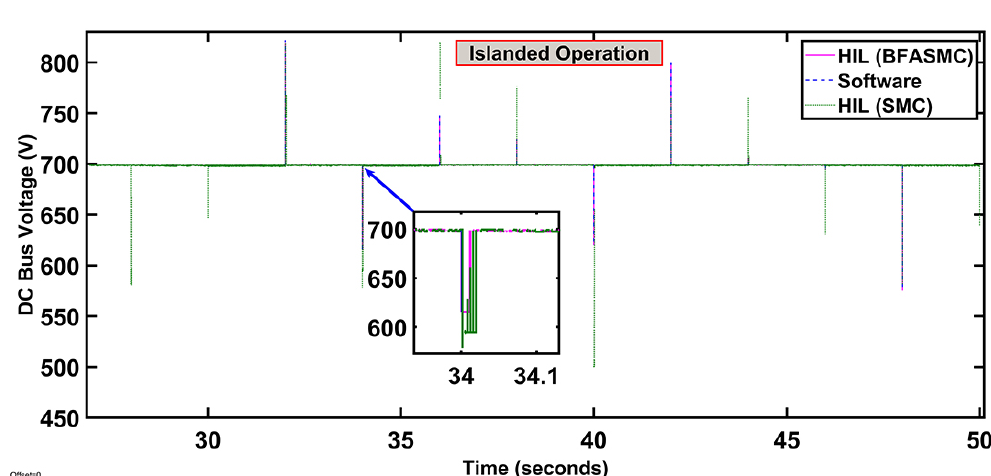
Figure 21. HIL DC bus comparison islanded